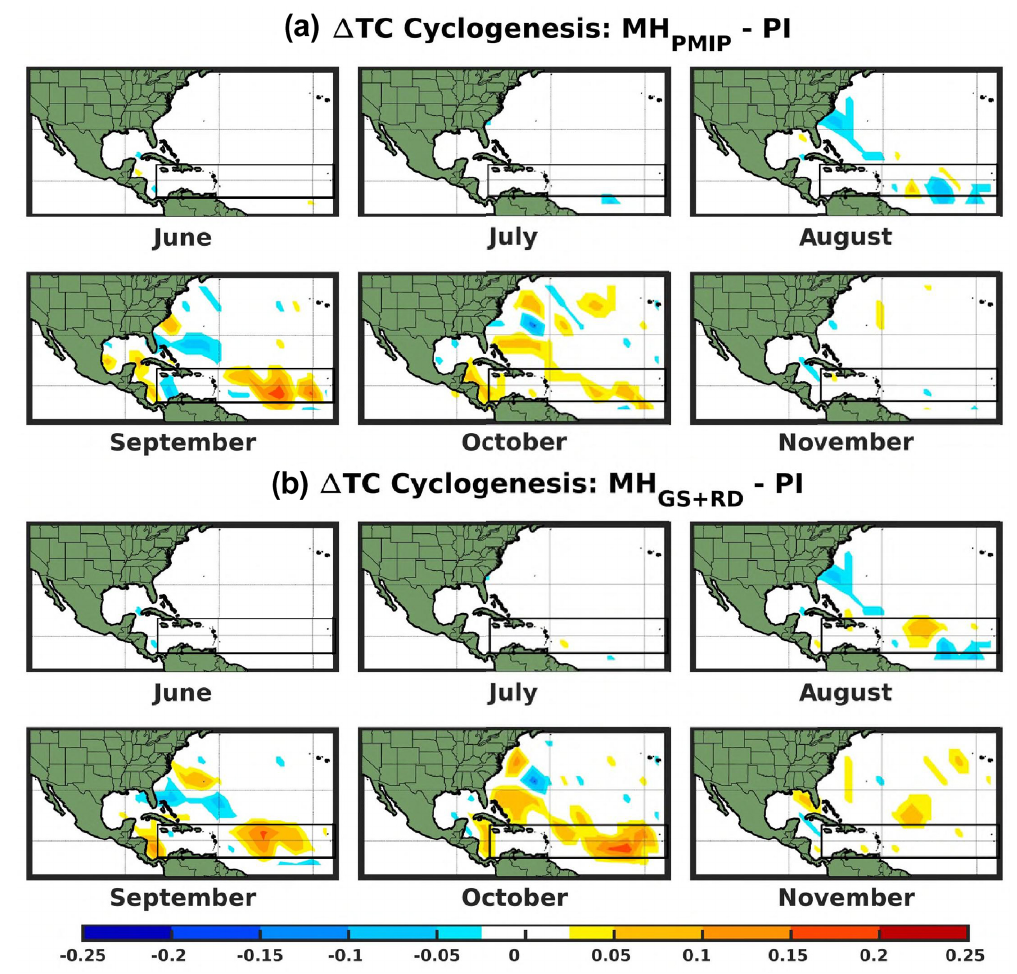
Figure A14. TC seasonal (JJASON) cyclogenesis density anomaly for the (a) MH PMIP and (b) MH GS + RD experiments relative to PI represented over a 5 ◦ mesh-grid Mercator projection. The black box shows the approximate present-day MDR.